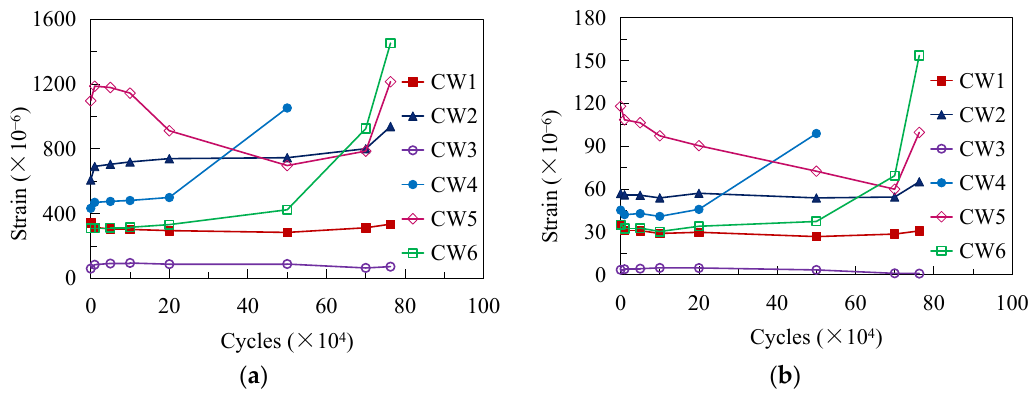
Figure 8. Strain development under cyclic loading: ( a ) P min ; ( b ) P max .